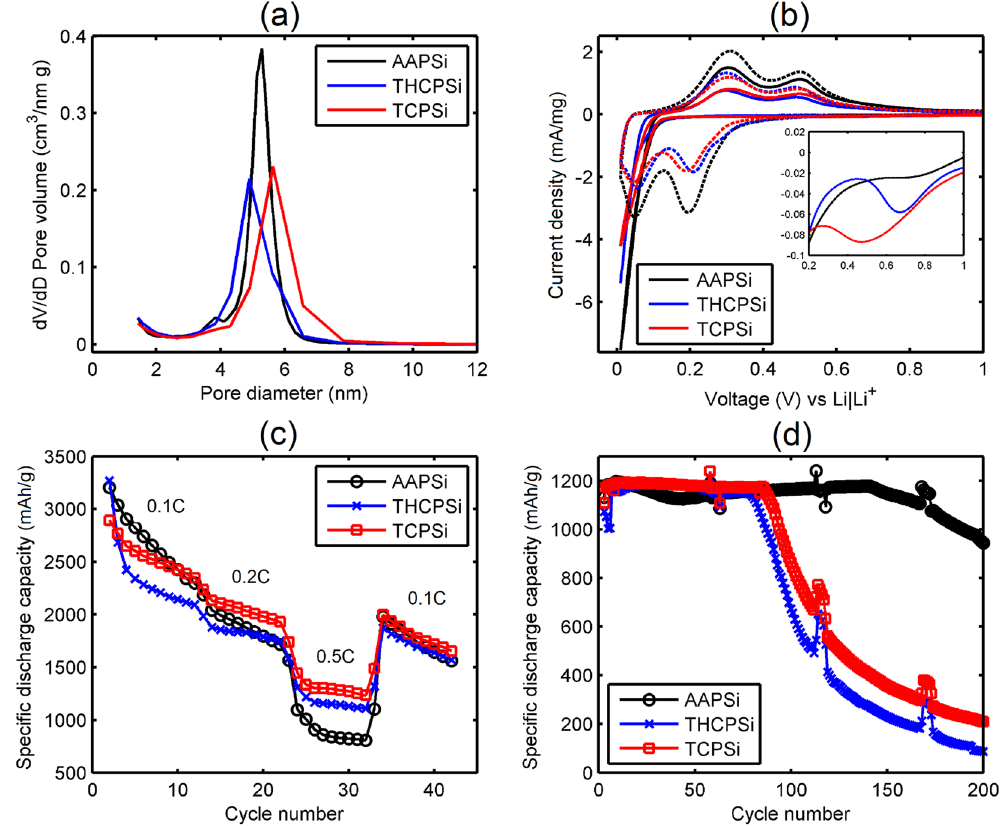
Figure 1. PSi pore size distribution and electrochemical measurements for different surface modifications. ( a ) Pore size distributions of the AAPSi, THCPSi and TCPSi samples. ( b ) Cyclic voltammetry results from scan #1 (solid line) and scan #4 (dashed line). Inset shows formation of SEI layer during the first scan. ( c ) Galvanostatic rate capability results for the AAPSi, THCPSi and TCPSi samples. Mass loading of silicon is 1.0 mg/cm 2 . ( d ) Galvanostatic capacity retention results with limited capacity of 1200 mAh/g. Cycling was done periodically: 5 × 0.1 C + 50 × 0.2 C while 1 C equals to 4200 mA/g. Mass loading of silicon is 0.6 mg/cm 2